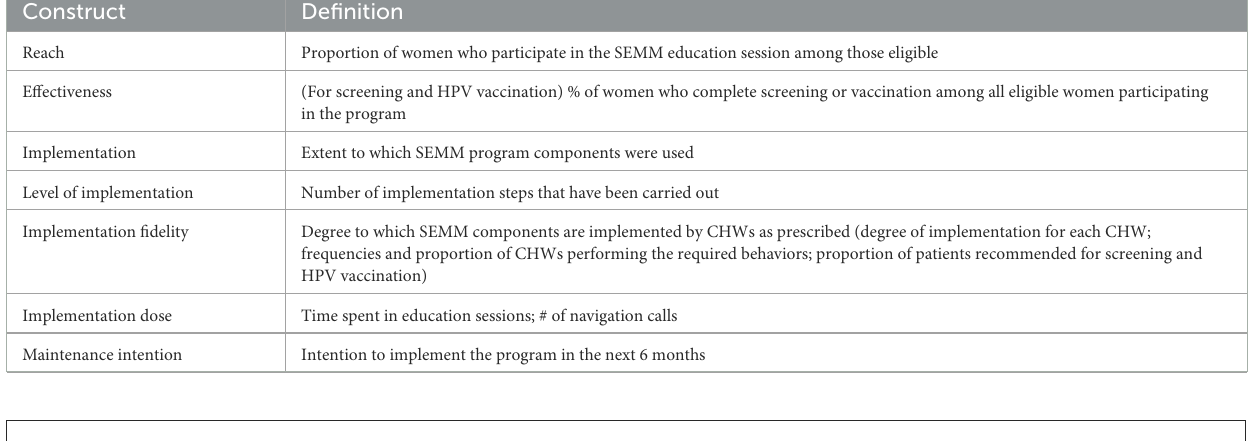
TABLE 7 RE-AIM framework utilized constructs defined.